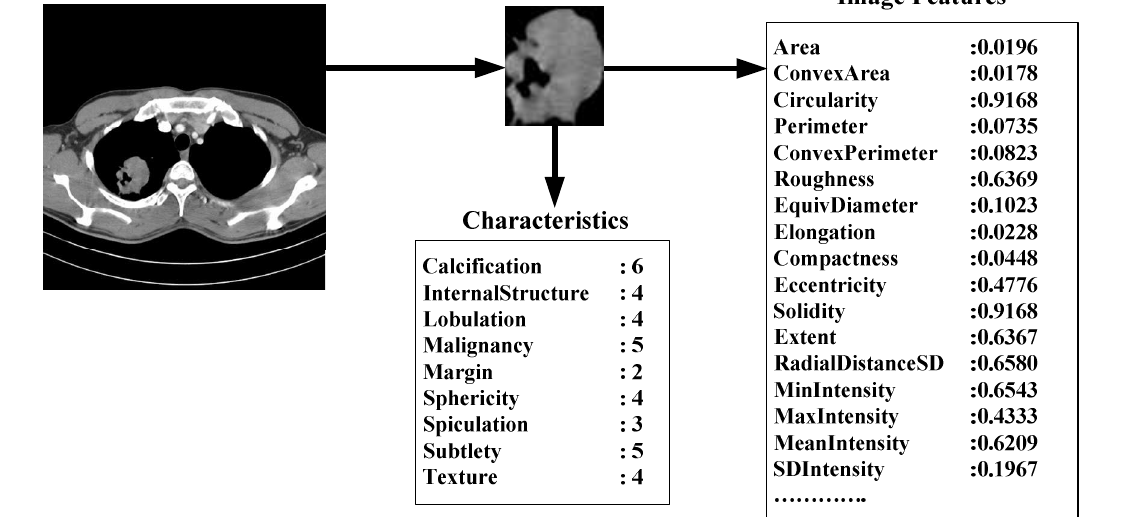
Figure 2. An example of nodule characteristics assigned by a radiologist and normalized low-level features computed from image